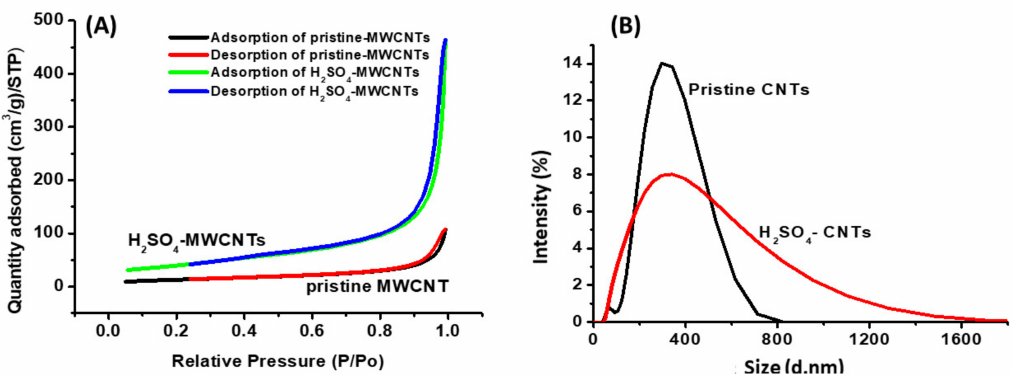
Figure 5. Porositometric and particle size properties of MWCNTs. BET isotherms for both the pristine (black curve for N 2 adsorption and red curve for desorption) and HCl-treated (green curve for N 2 adsorption and blue curve for desorption) MWCNTs ( A ). Particle size distribution of pristine and H 2 SO 4 -treated (for improving dispersibility and hydrophilicity) carbon nanotubes ( B